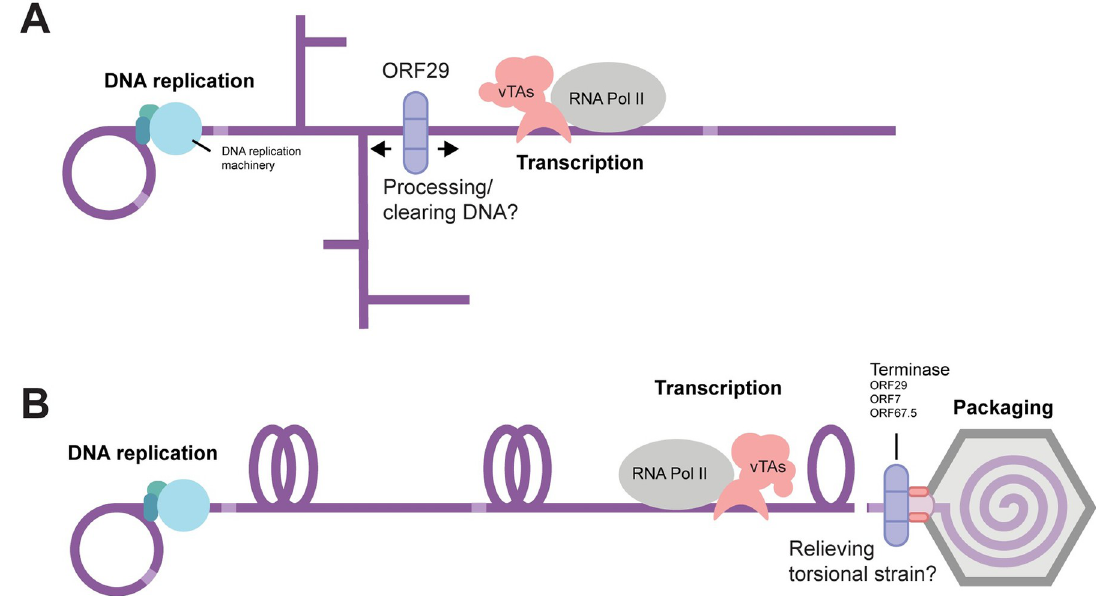
Fig 6. Models for the contribution of ORF29 to viral transcription. (A) Newly replicated concatemeric herpesvirus genomes are shown with aberrant DNA structures that are thought to arise during replication. As a factor that can both move along and cleave DNA, ORF29 may function to resolve DNA structures that could stall RNA polymerase or are otherwise detrimental to transcription. Light purple regions on the DNA denote terminal repeats at the end of each unit length genome. (B) DNA replication and transcription can generate torsional strain shown as supercoiled DNA. If left unresolved, torsional strain can impair transcription. ORF29 activity may relieve accumulated torsional strain to allow for full viral